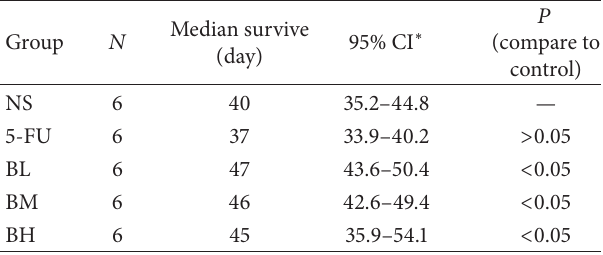
Table 2: Survival time of mice with xenograft tumor. Median survive Group 𝑁